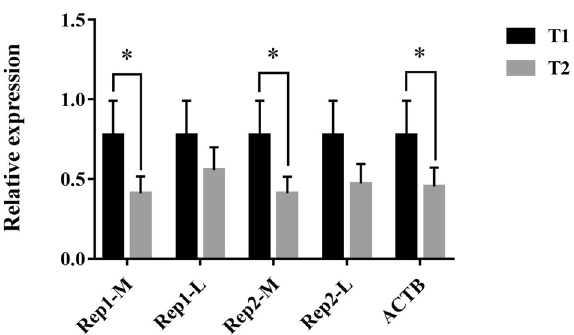
Figure 6. Validation of the selected reference genes by detected expression of the FSHR gene in the testis at different reproductive stages. T1 reproduction period, T2 reproduction decline period, Rep1-M/L the most stable ( HPRT1 ) and least stable ( B2M ) reference genes, Rep2-M/L the two most stable ( HPRT1 and LDHA ) and two least stable ( B2M and TFRC ) reference gene combinations; * P <